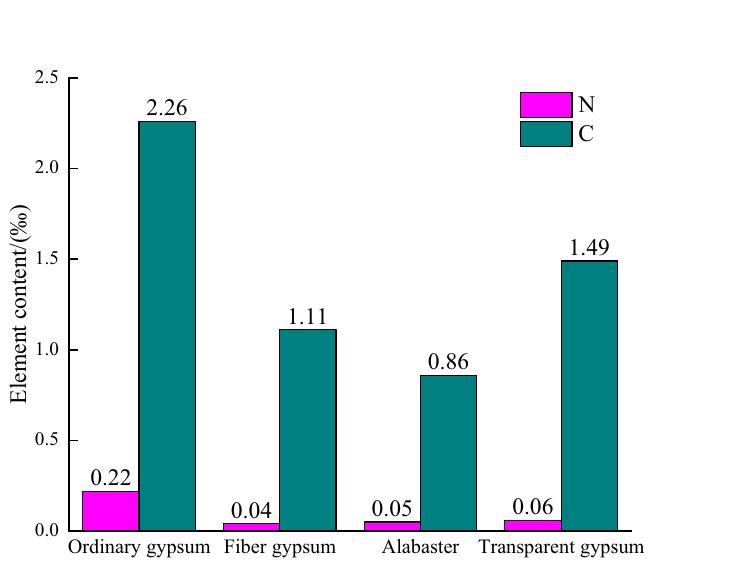
Figure 5. The content of C and N elements in different gypsum rocks based on element